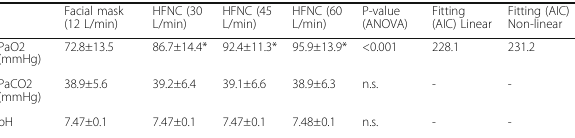
Table 107 (abstract A336). Effects of HFNC on gas exchange Facial mask